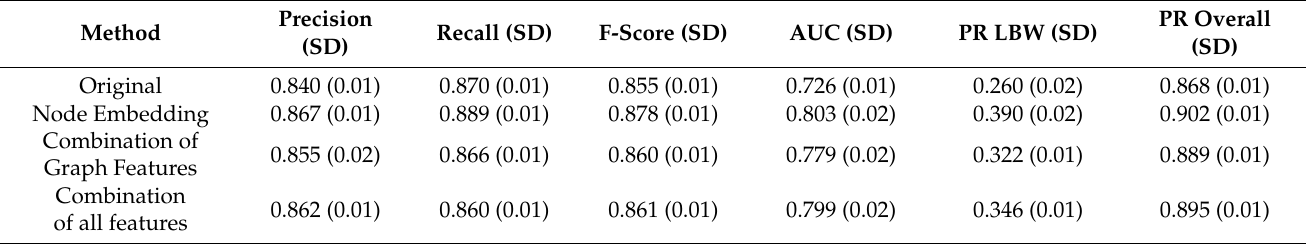
Table 4. Experiments performed using a naïve Bayes classifier.